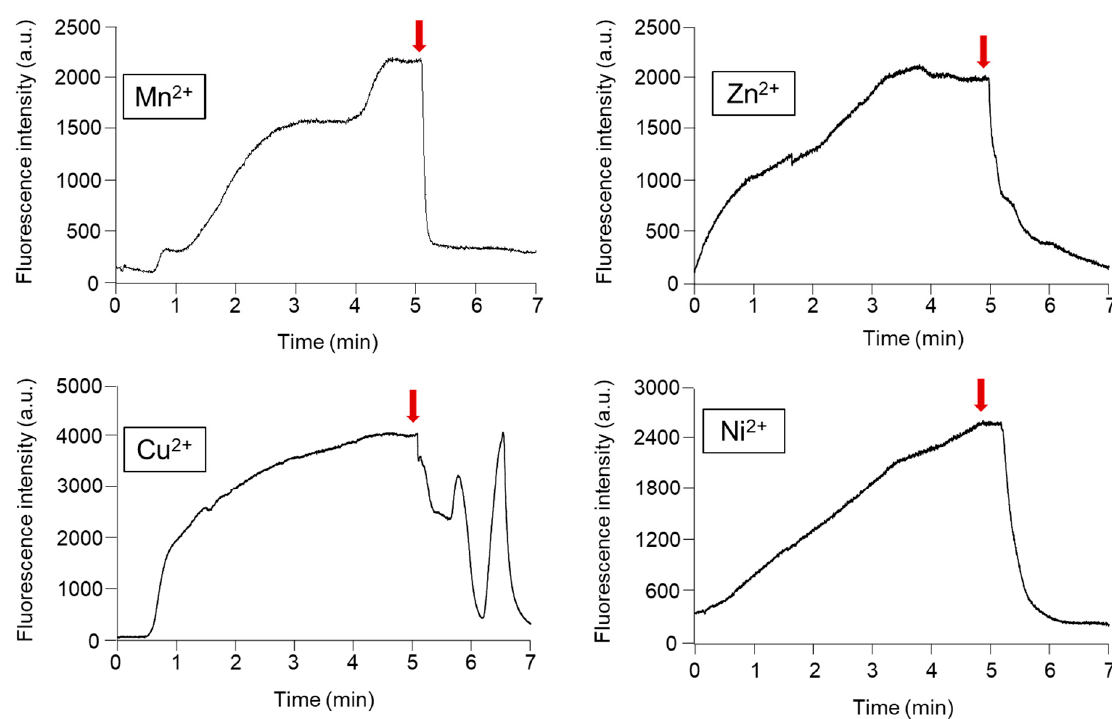
Figure 4. Time course of the changes in the fluorescence intensity due to concentration and release of the 10 − 9 M 5-(4,6-dichlorotriazinyl)aminofluorescein (DTAF)-labeled monophosphorylated β -casein at the channel crossing point in the Phos-tag acrylamide gel utilizing various metal ions. Red arrows indicate the switching voltage for release the preconcentrated DTAF-labeled monophosphorylated β -casein.